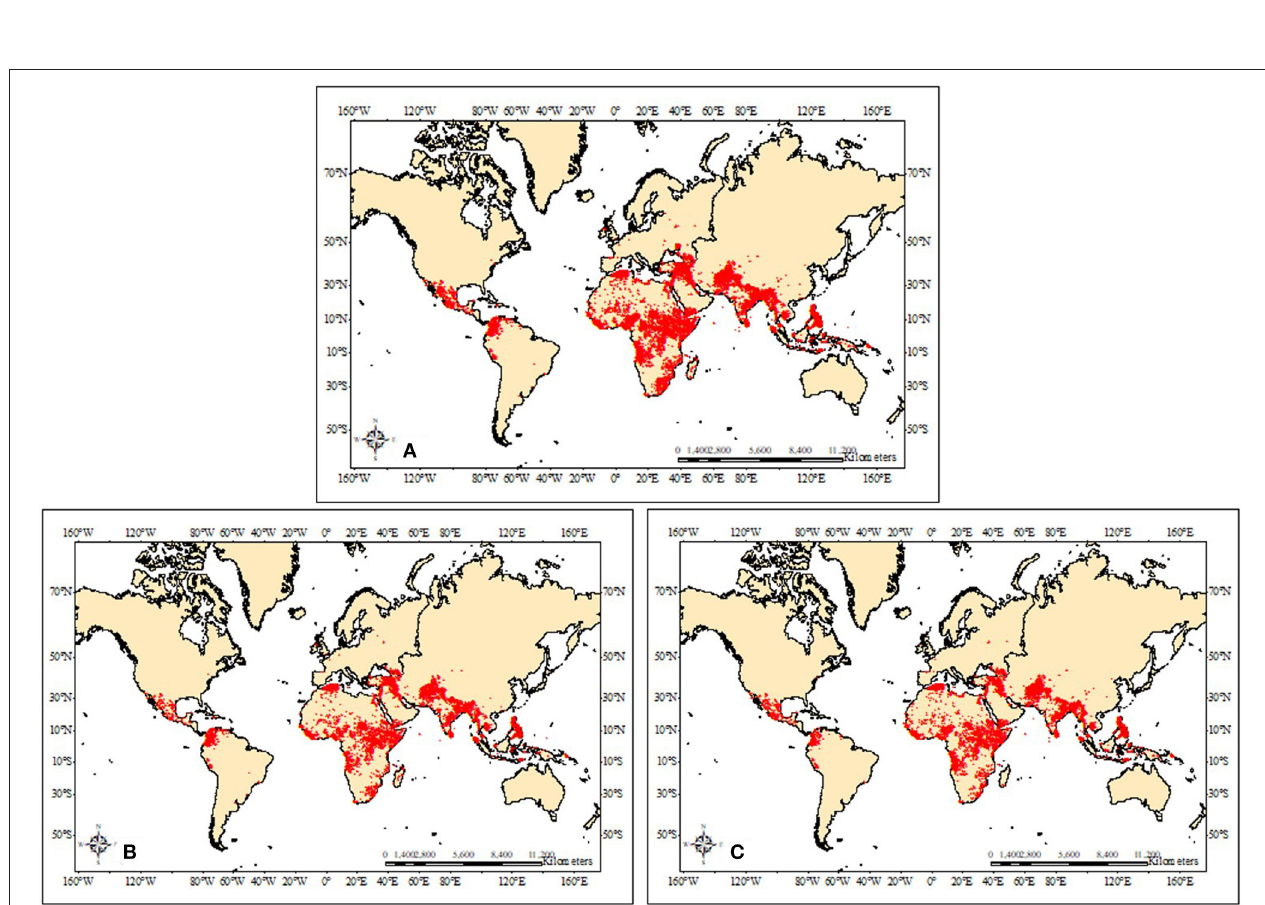
FIGURE 2 | Distribution of conflicts from 1989 to 2014 (A) All years; (B) El Niño years; (C) La Niña years.